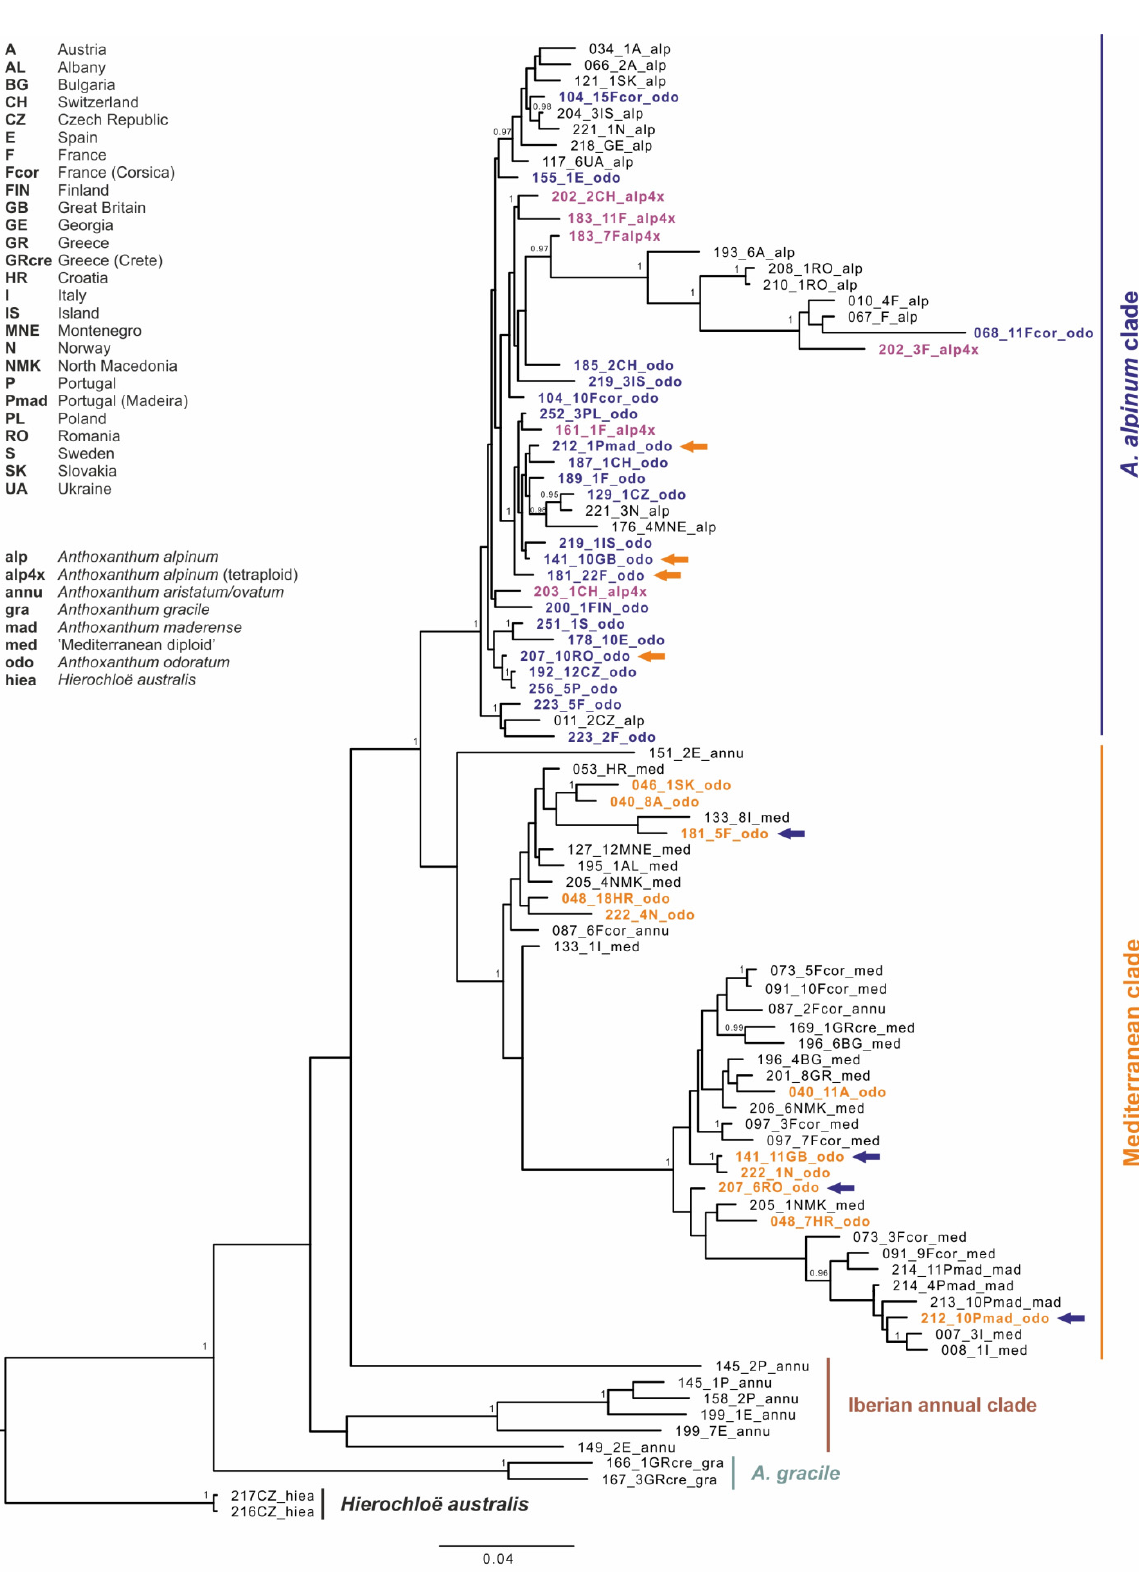
Figure 4. Maximum clade credibility tree obtained from the Bayesian analysis of nuclear DNA marker GBSSI. The numbers by nodes represent Bayesian posterior probabilities if over 0.95. Colored arrows indicate individuals that exhibit two alleles of GBSSI in different clades.